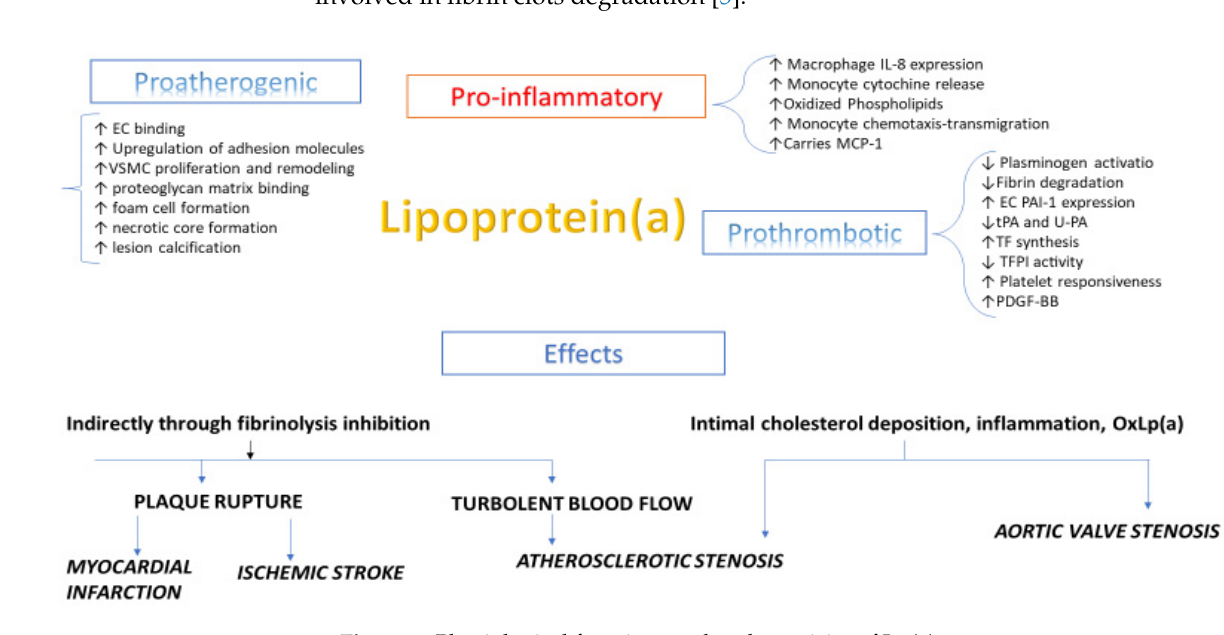
Figure 1. Physiological functions and pathogenicity of Lp (a).